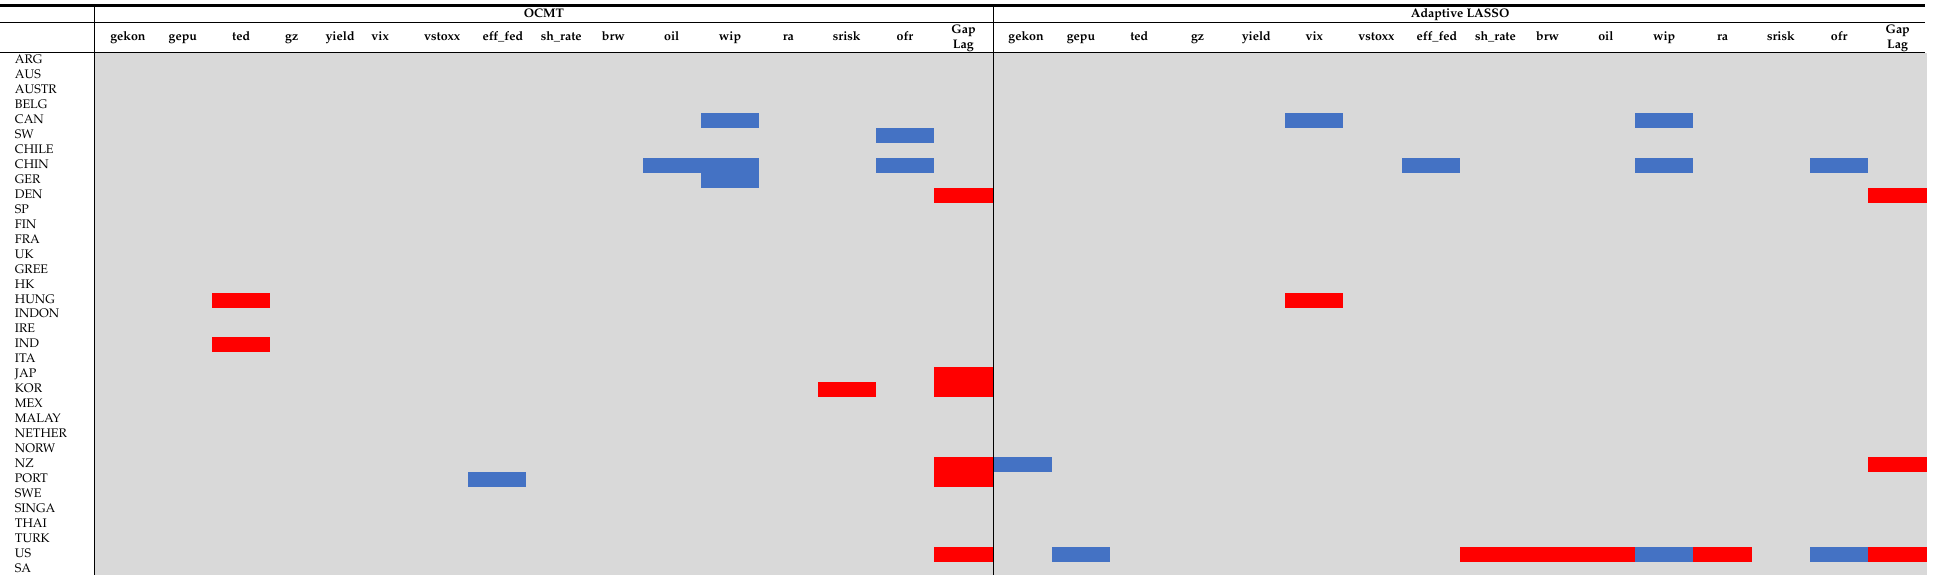
Table 3. Global determinants of credit-to-GDP gaps in